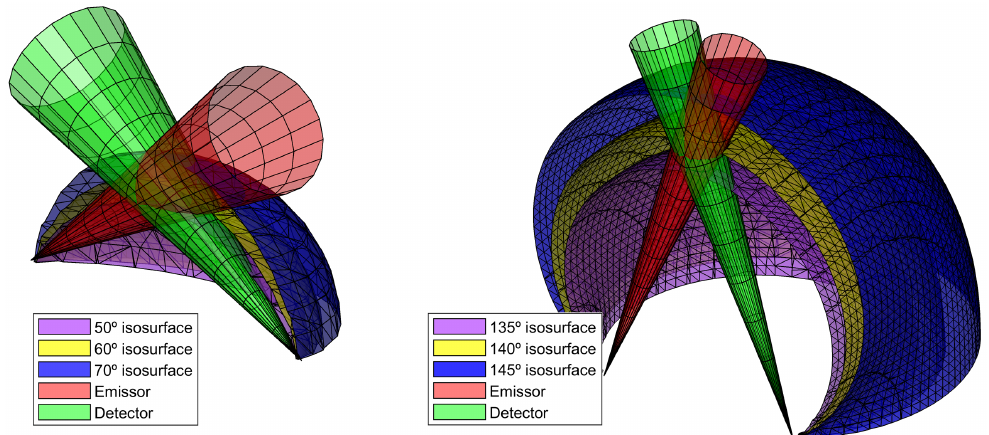
Figure 10. Scattering angleisosurfaces for different